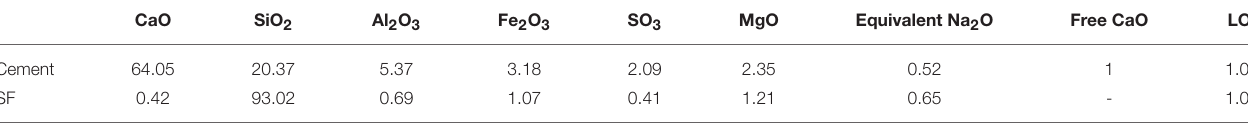
TABLE 1 | Chemical composition of the ordinary portland cement (%). CaO SiO 2 Al 2 O 3 SO 3 Cement